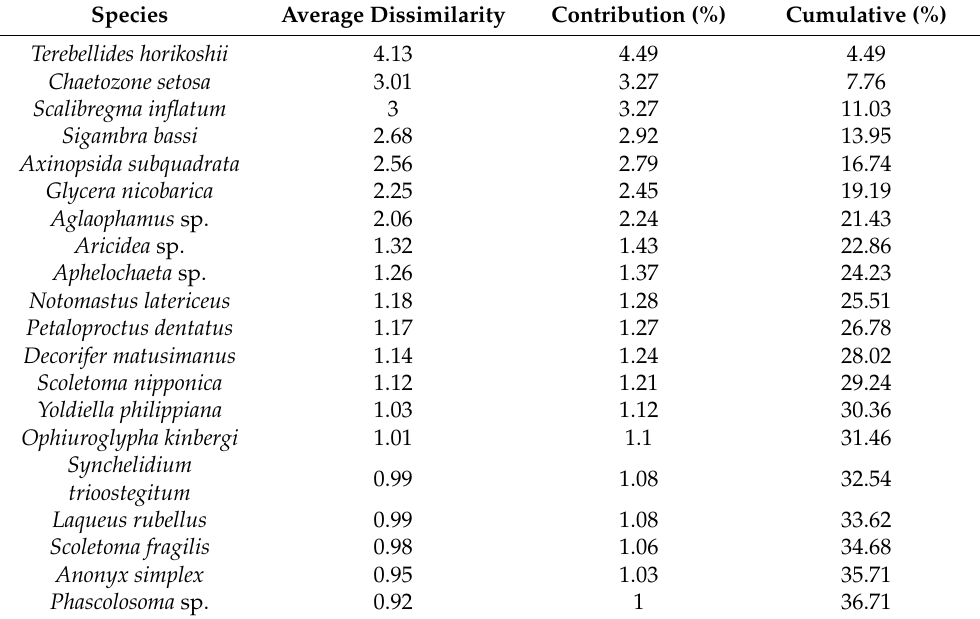
Table 4. Similarity percentage (Simper) analysis of macrobenthos groups.